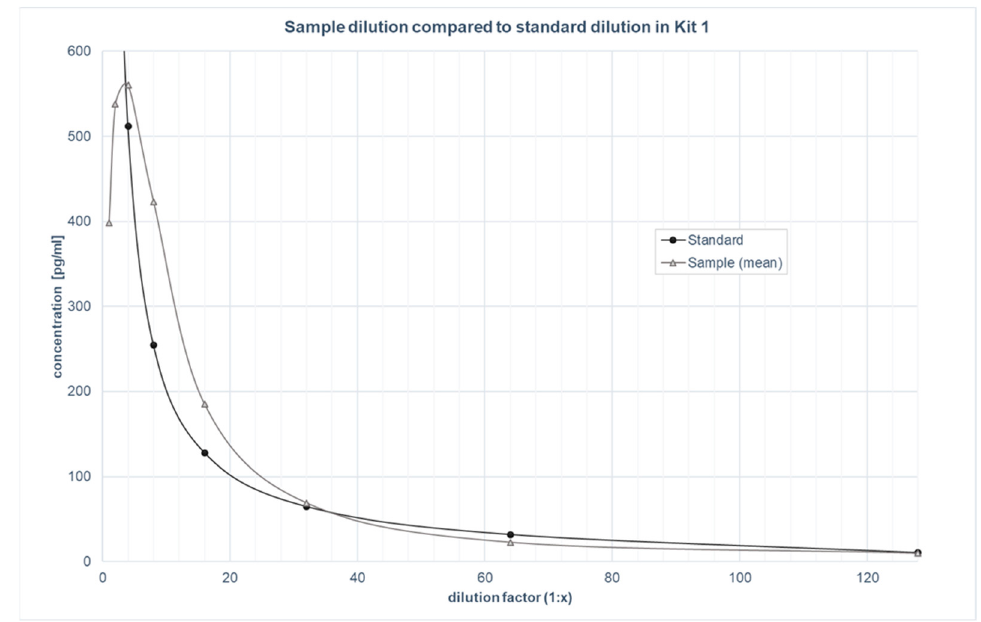
Figure 1. Parallelism: Sample dilution of kit 1, compared to standard dilution.